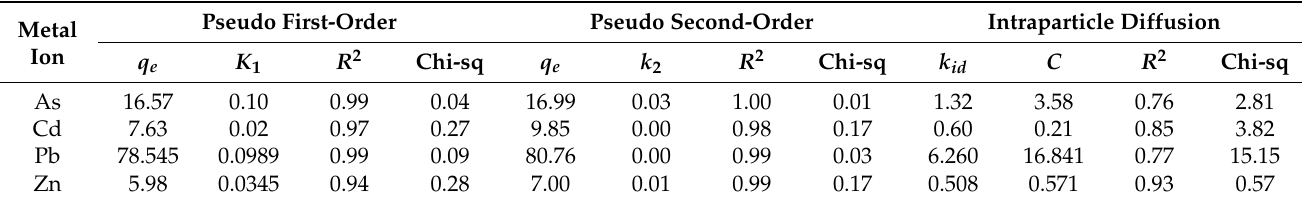
Table 4. Parameters of the kinetic models for the HMB-Act/CH composite.